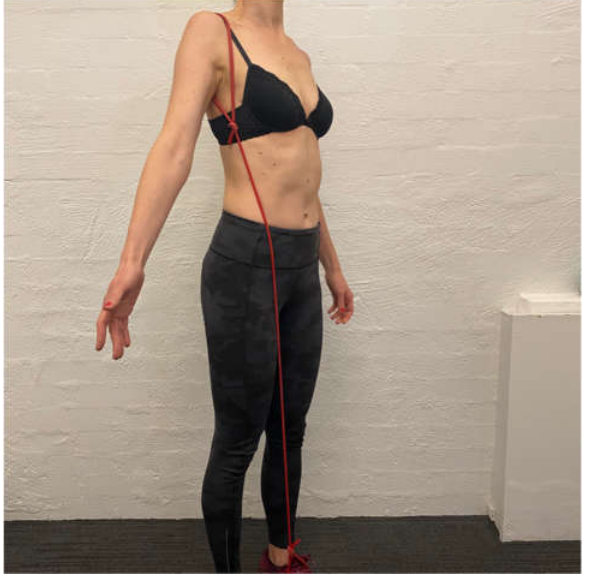
Figure 4. Upward rotation/elevation drill with scapular resistance band anchored to the foot.